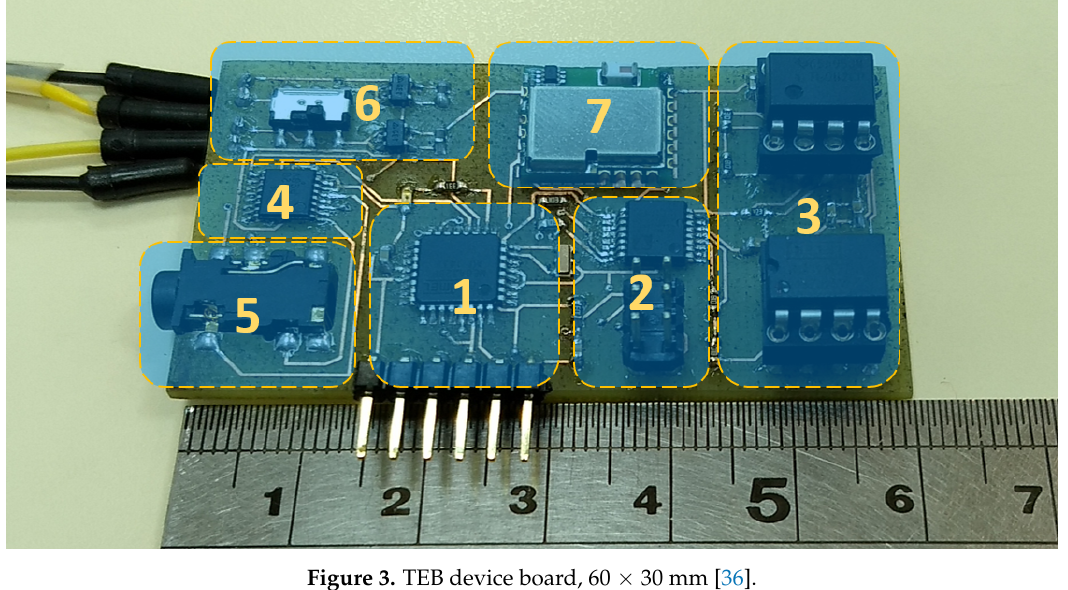
Figure 3. TEB device board, 60 × 30 mm [36].